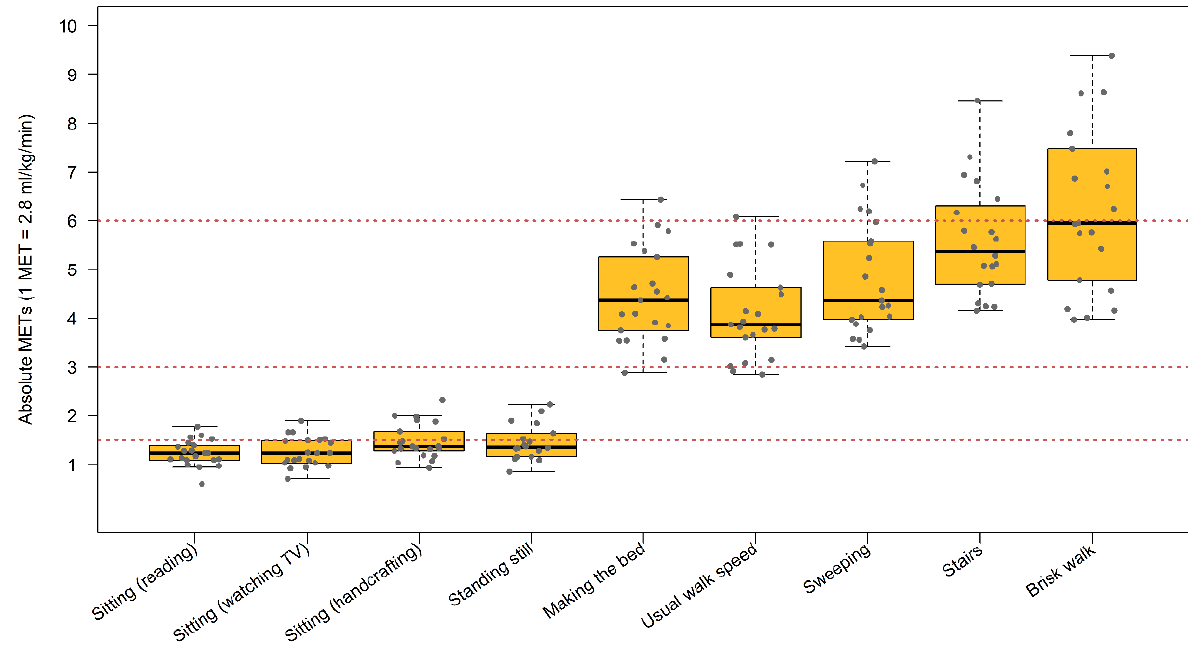
Figure A1. Box plot for the METs to each activity performed in the cross-validation sample. MET: metabolic equivalent of the task.